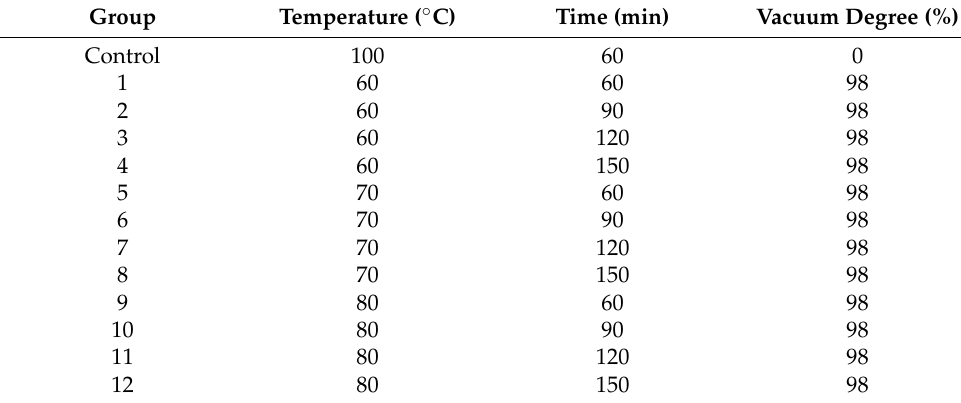
Table 1. Temperature, Time, and Vacuum Conditions Applied in This Study for Cooking Chicken Breast